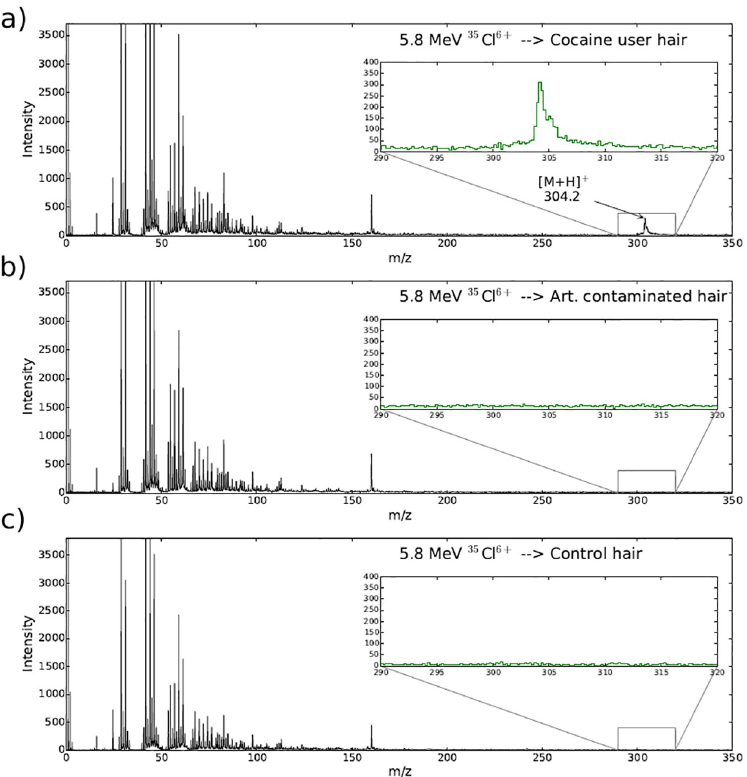
Fig 5. Measured MeV-SIMS spectra of three hair samples. The cocaine peak was measured only in the sample from the actual cocaine user, while the spectra of the artificially contaminated hair exhibits no such peak as the ion beam was focused on the inside of the hair